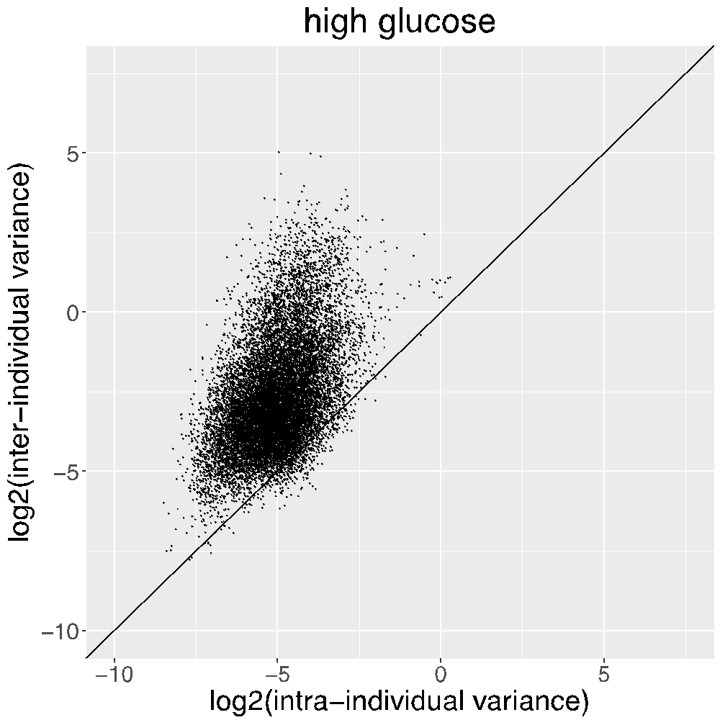
Intra- and interindividual transcriptome variation in high glucose treatment.Intraindividual variation in the transcriptome was quantified among biological replicates and compared to interindividual variation, for individual genes (2,3), and comparing the two distributions of all genes (3,4). Source and code files for these plots are available in Figure 1—source data 7 and 8, and Source code 4.